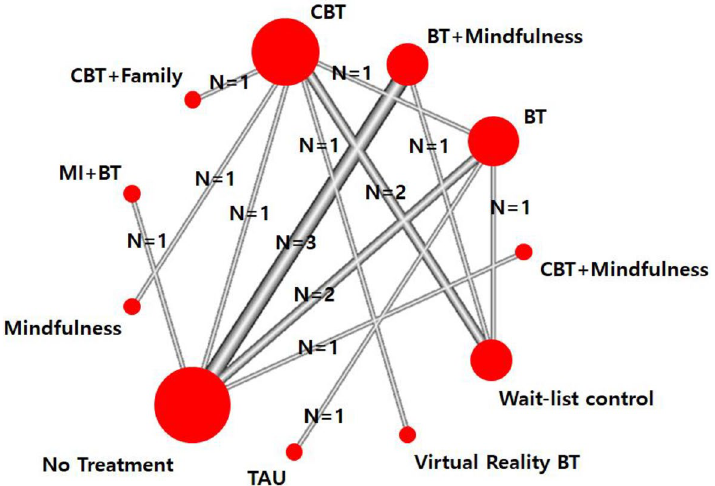
Figure 3. Network plot for excessive gaming interventions. Width of lines and size of circles are proportional to the number of studies in each comparison. BT behavioral therapy, CBT cognitive behavioral therapy, Family family intervention, MI motivational interviewing, TAU treatment as